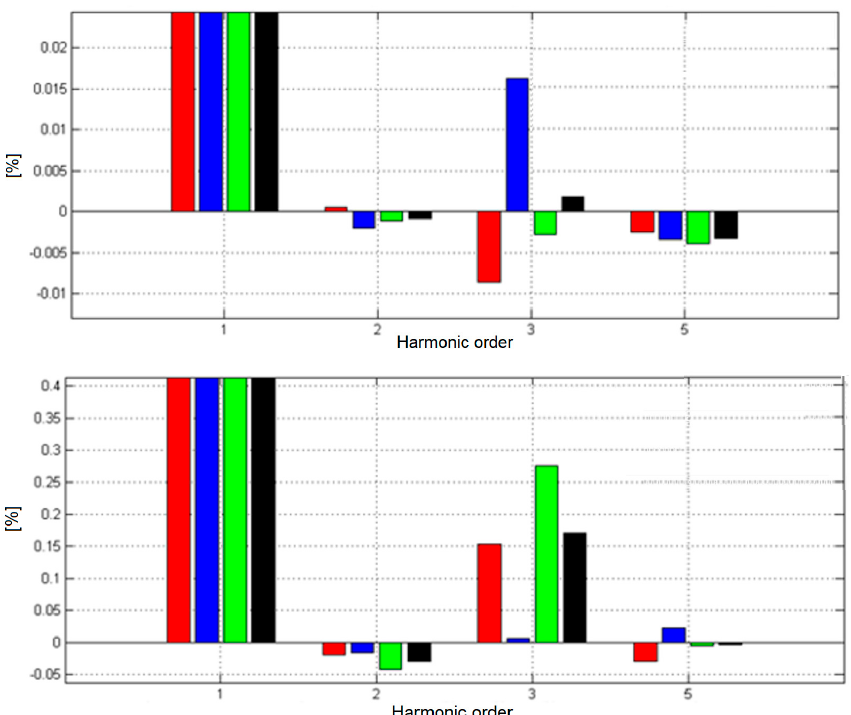
Figure 24. Harmonic spectra of three-phase currents ( top ) and voltages ( bottom )—quan- tities acquired at the terminals of the main generator for the active power of 171 MW.